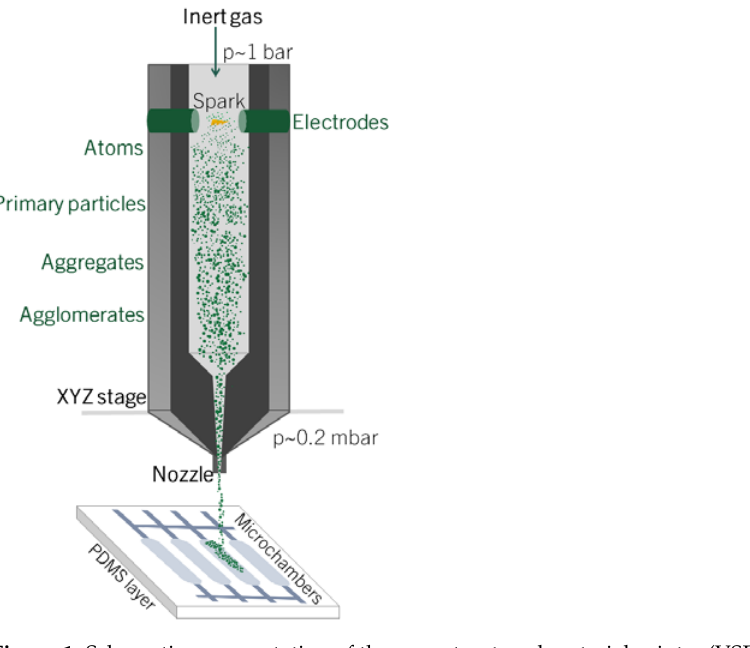
Figure 1. Schematic representation of the nanostructured material printer (VSP-P1 NanoPrinter) used for the deposition of nanoparticle films in the chambers of a multiplexed PDMS microfluidic device.